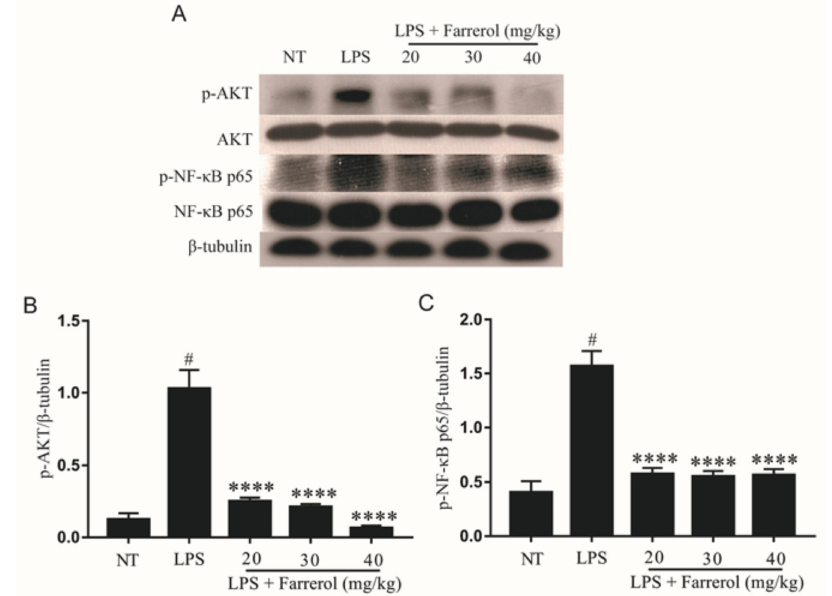
Figure 5. Farrerol inhibited the phosphorylation of protein kinase B (AKT) and NF- κ B signal pathways protein in LPS-induced mouse mastitis. The protein levels of p-AKT ( A , B ) and p-NF- κ B p65 ( A , C ) were measured by Western blot. Data were presented as mean ± SEM ( n = 3). # p < 0.05 vs. NT group; **** p < 0.0001 vs. LPS